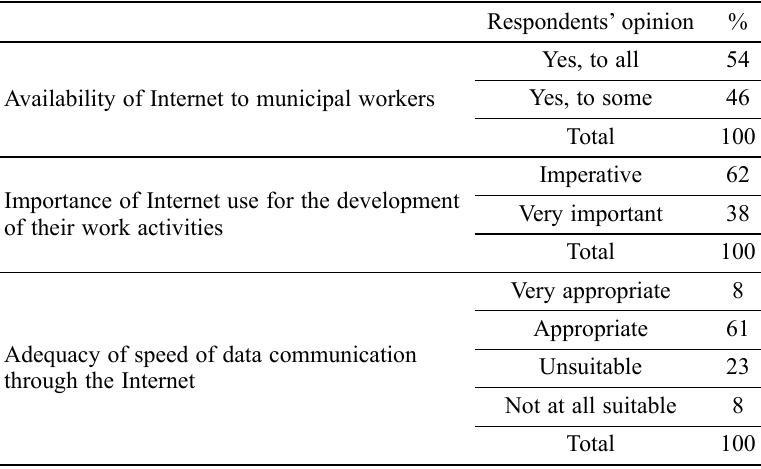
Table 4. Availability, importance and adequacy of Internet in municipal services